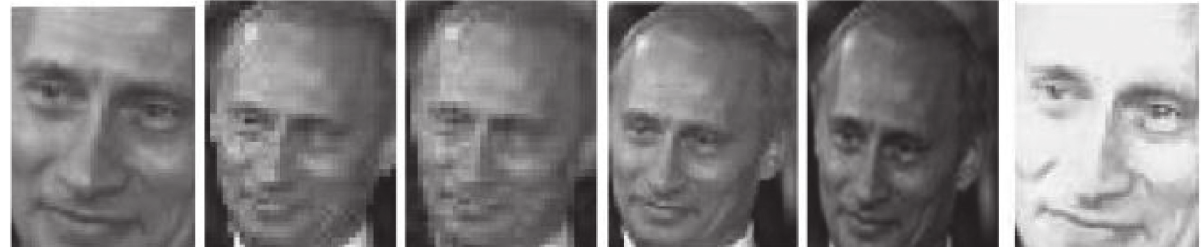
Figure 2: 1 st column, corrupted video face image; 2 nd column, the low-rank component by [31]; 3 rd column, the low-rank component by [30]; 4 th column, the low-rank component by [38]; 5 th column, the low-rank component by [39]; 6 th column, the low-rank component by the proposed